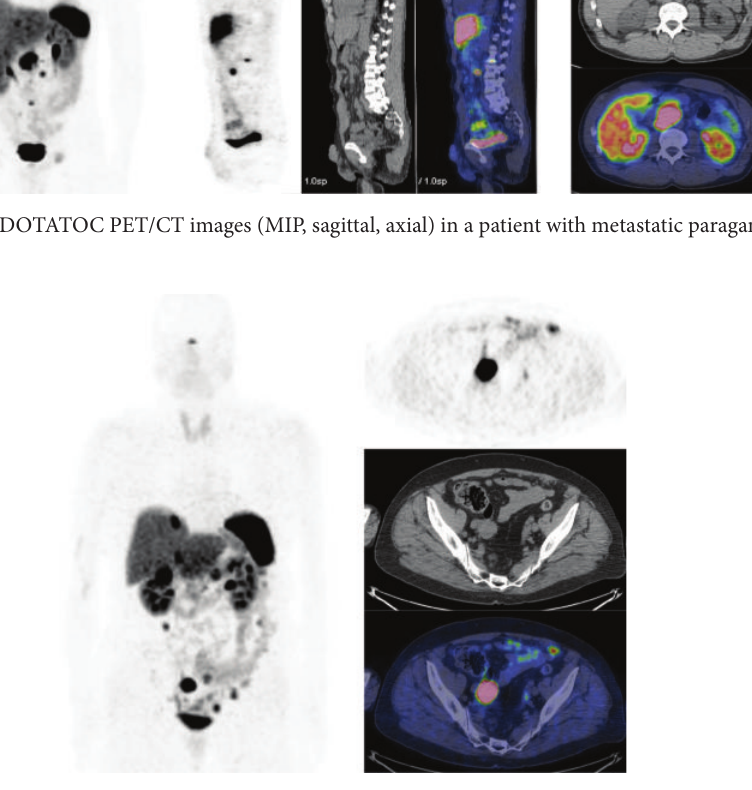
Figure 2: 68 Ga-DOTATOC PET/CT images (MIP, axial) in a patient affected by metastatic phaeocromochytoma.